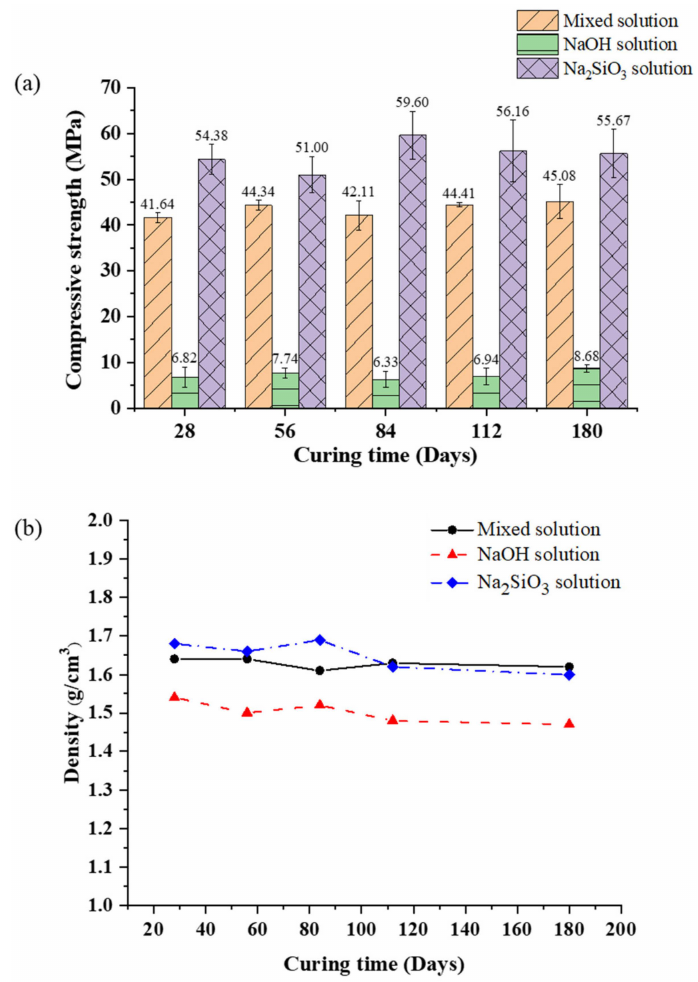
Figure 9. ( a ) Compressive strength and ( b ) bulk density of the mixed solution-based AAM, NaOH solution-based AAM, and Na 2 SiO 3 solution-based AAM, for different curing